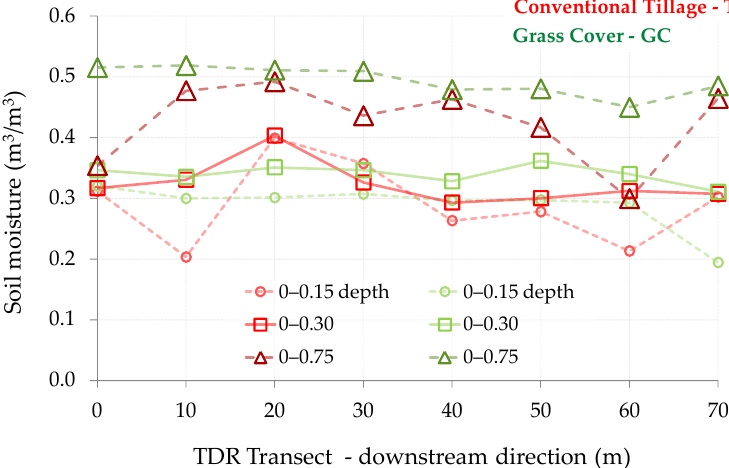
Figure 20. Carpeneto site, 21 March 2016. Soil water content monitored along the two TDR transects (conventional tillage and grass cover) depicted in Figure 19.